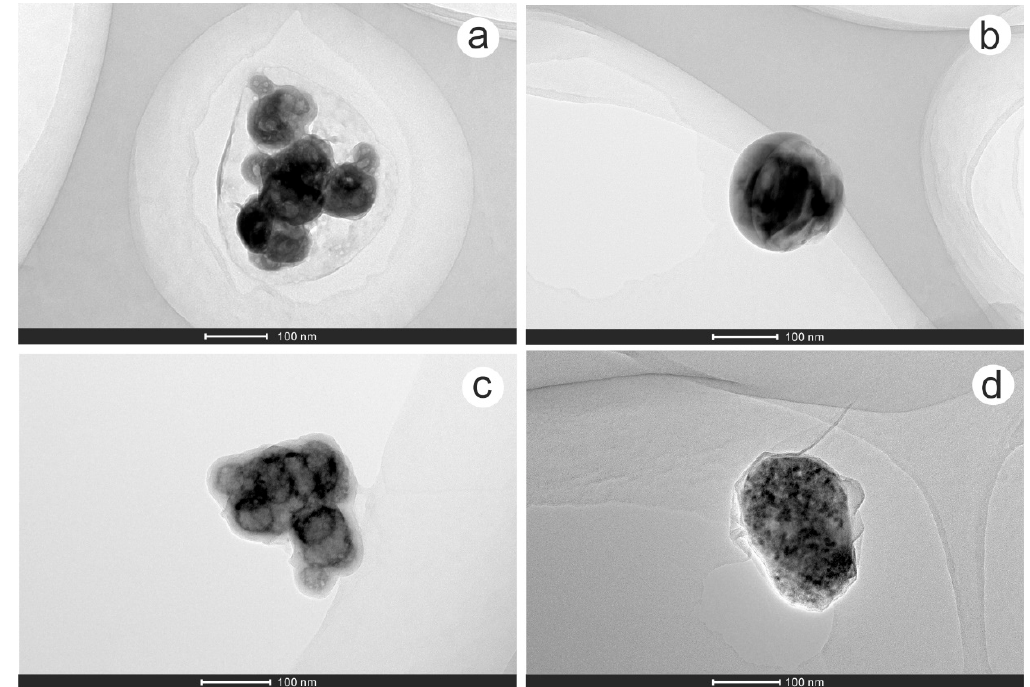
Figure 5. Pb-, Zn-, and Cu-bearing particles in soils over gold deposit; ( a ) TEM image of a Pb- and Zn-bearing particle aggregation; ( b ) TEM image of a Zn-bearing particle; ( c ) TEM image of a Cu-bearing particle aggregation; ( d ) TEM image of a Zn-bearing particle.